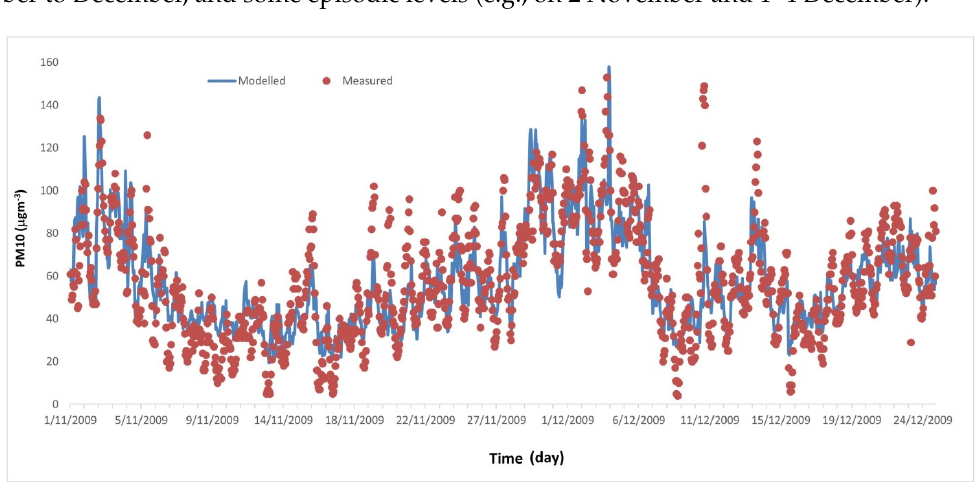
Figure 3. Comparison between the ANN modeling results and the measurements. Temporal variation in PM 10 as predicted by the ANN model. The measured data are shown as circles.